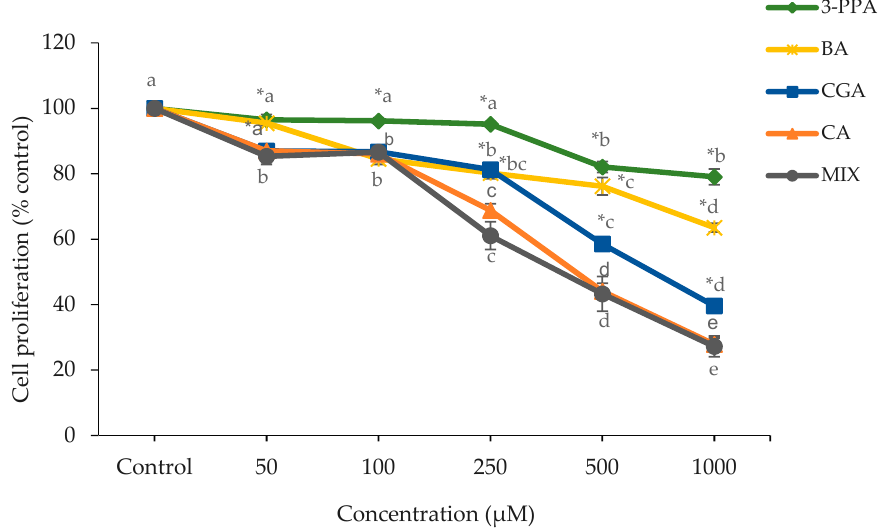
Figure 1. Effect of treatment with different doses of CGA, CA, 3-PPA, BA and MIX for 24 h on Caco-2 cell proliferation as measured by the MTT assay. Data are represented as mean ± standard error (SE). Statistical analysis was performed via two-way analysis of variance (ANOVA) using treatment and dose as factors. Doses within the same treatment not sharing common letters are significantly different ( p < 0.05). The symbol * represents a significant difference ( p < 0.05) of CA and MIX as compared to CGA, 3-PPA and BA at a specific dose. CGA = chlorogenic acid; CA = caffeic acid; 3-PPA = 3-phenylpropionic acid; BA = benzoic acid; MIX = equimolar mixture of the four tested compounds.